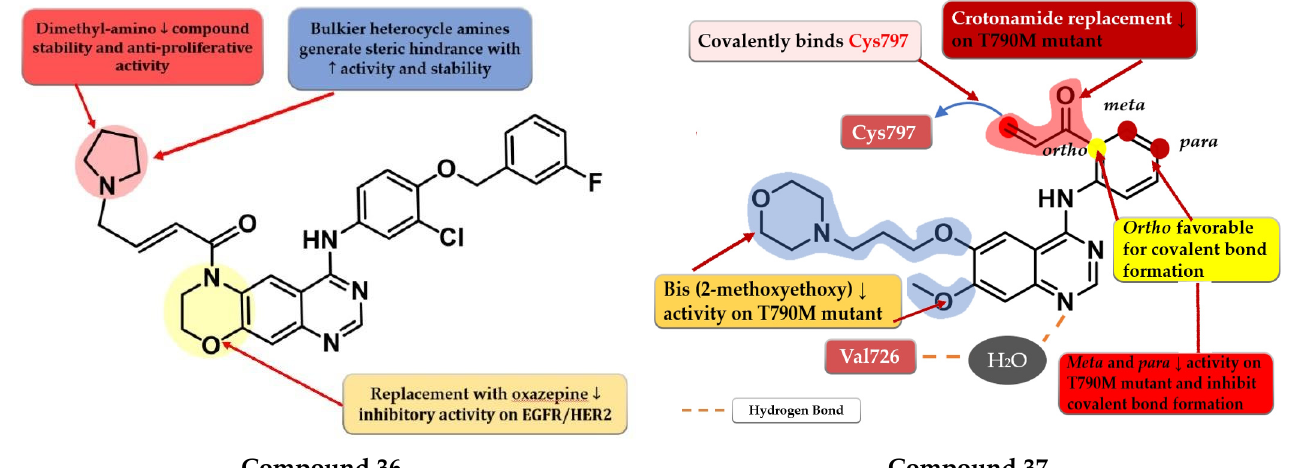
Figure 24. Structure–activity relationship of compound 36 , as reported by Sun et al. [180]; structure– activity relationship and molecular docking of compound 37 covalently bonded in the human EGFR T790M kinase domain (PDB ID 4P5G), as reported by Liu et al.